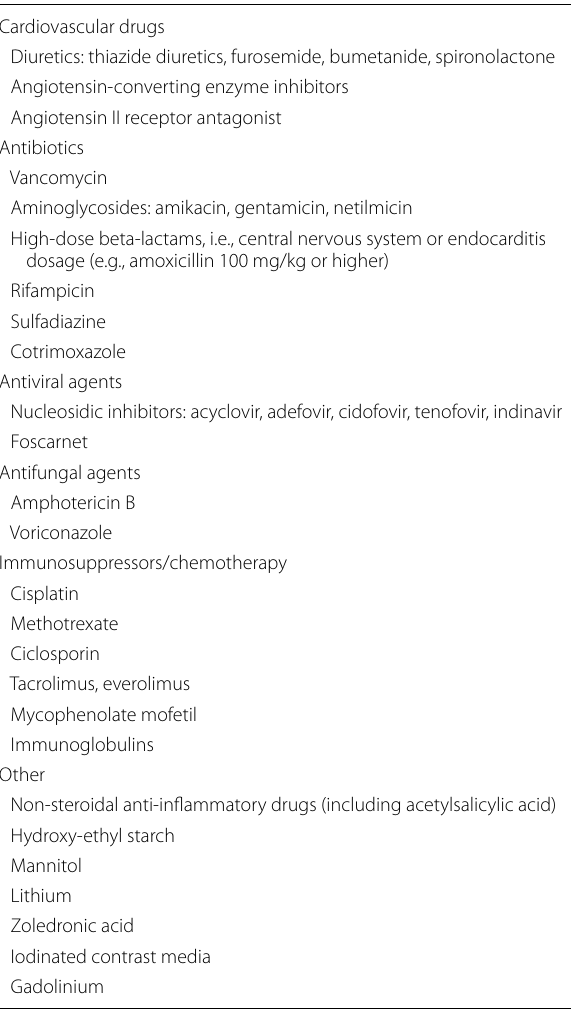
Table 1 Potential nephrotoxic drugs recorded Cardiovascular